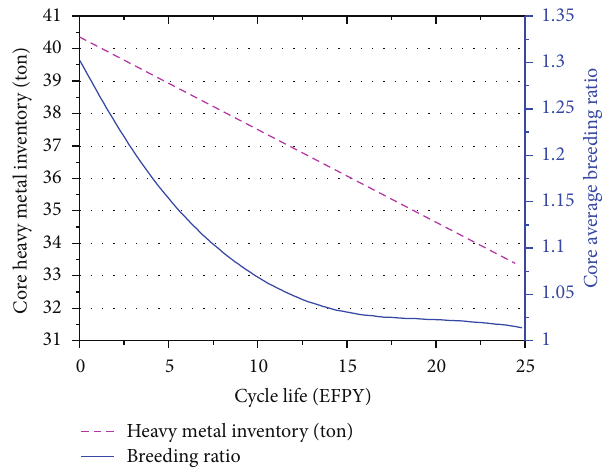
Figure 22: Core heavy metal inventory and breeding ratio versus cycle lifetime.